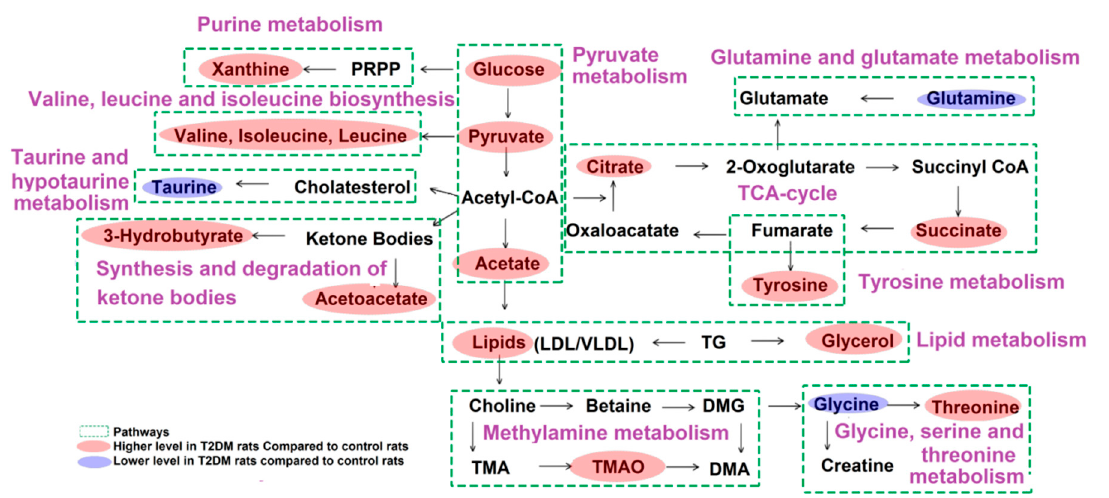
Figure 6. Schematic diagram of the metabolic pathways. Compared with the control group, red and blue metabolites represent increased and decreased levels, respectively.